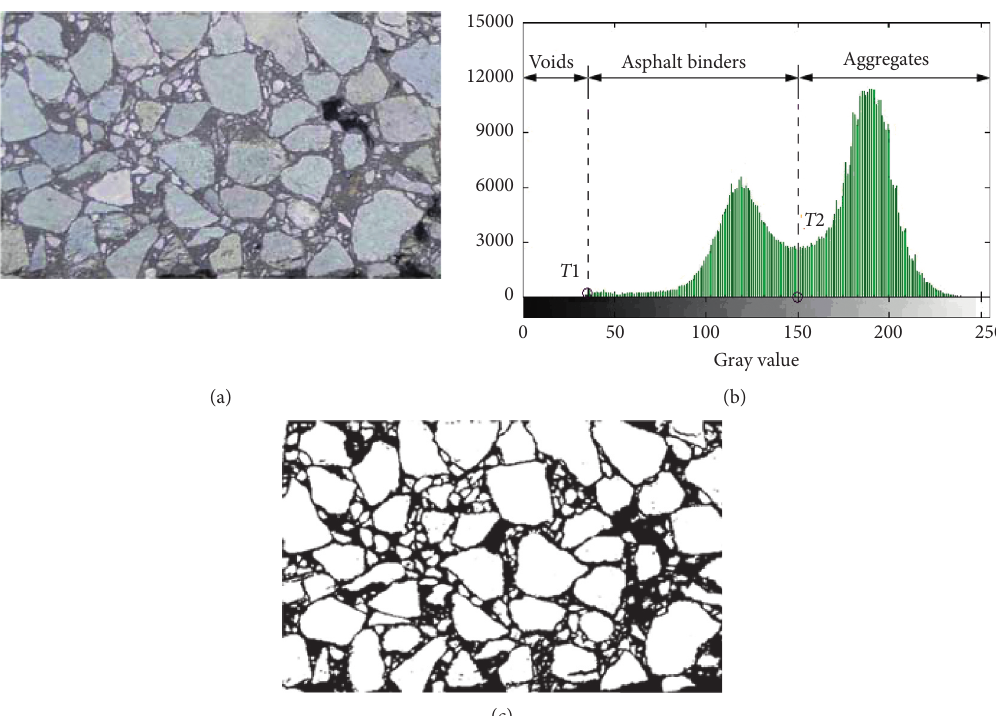
Figure 4: Image processing: (a) original image; (b) gray histogram; (c) binary image (reproduced from Shi et al. [12]).